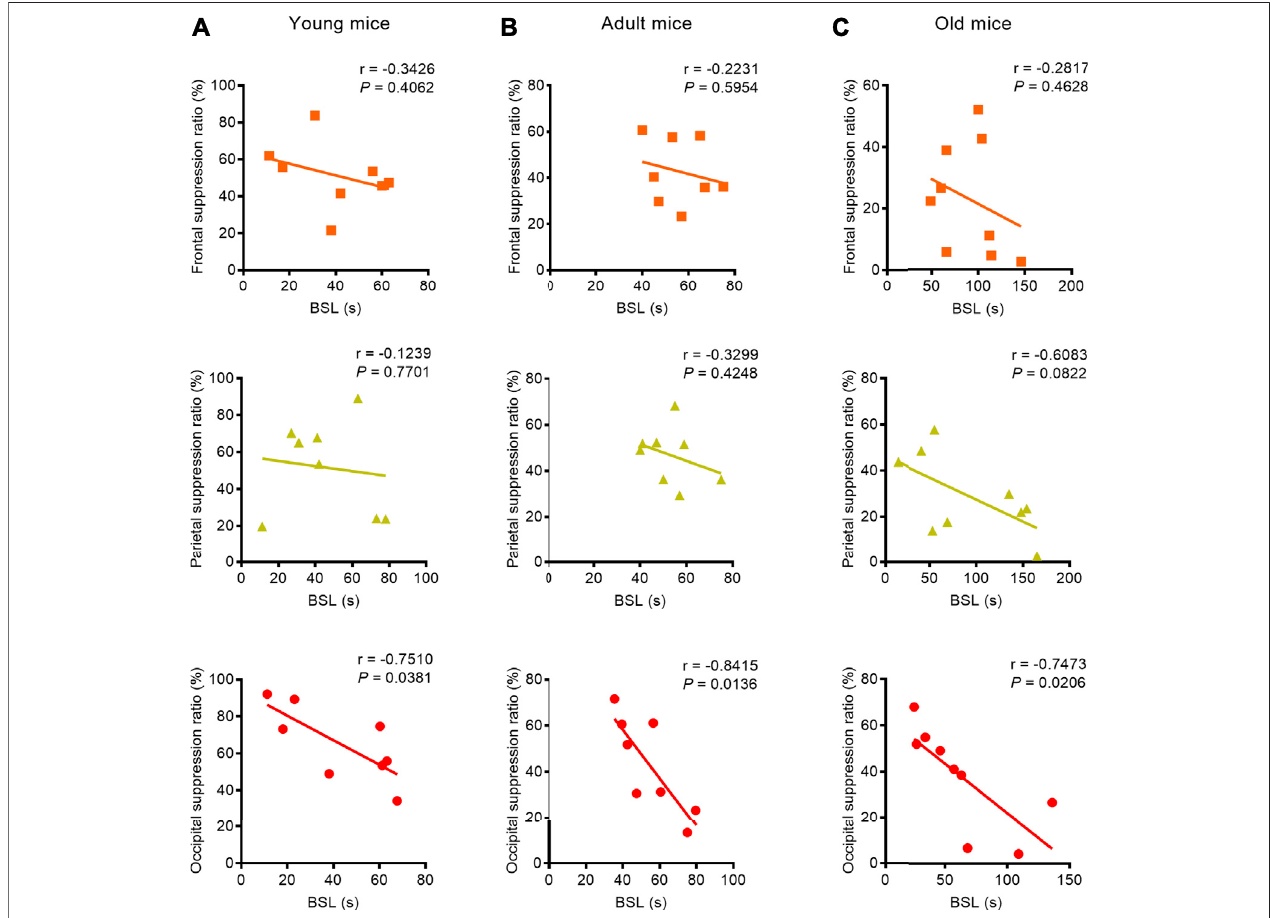
FIGURE 4 | Correlation between BLS and BSR in mice of different ages under 1.5% iso fl urane anesthesia. (A) Correlation analysis revealed that the BSL was not correlated with BSR in the frontal and parietal EEG recordings in young mice ( n (cid:1) 8, respectively), while the occipital lobe EEG recording showed a strong negative correlation ( n (cid:1) 8). (B) In the adult group, BSL was not correlated with BSR in the frontal or parietal EEG recording ( n (cid:1) 8, respectively); only the occipital EEG recording indicated a strong negative correlation between BSL and BSR ( n (cid:1) 8). (C) In the old group, no correlation was found between BSL and BSR in frontal lobe ( n (cid:1) 9), and the parietal showed a weak negative correlation between BSL and BSR ( n (cid:1) 9); in the occipital lobe, the correlation analysis revealed strong negative correlation between BSL and BSR ( n (cid:1) 9). These results indicate that the occipital lobe may be the best suited for monitoring the depth-of-anesthesia under deep anesthesia.